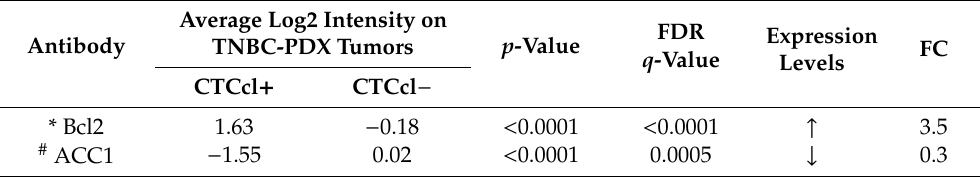
Table 1. Di ff erentially expressed proteins in TNBC PDX tumors with versus without CTCcls based on RPPA analysis. Average Log2 Intensity on Antibody TNBC-PDX Tumors p -Value